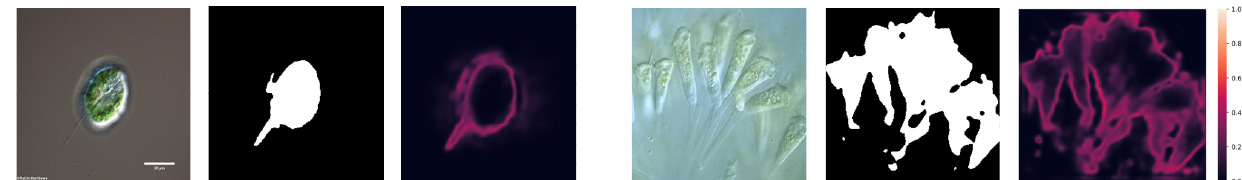
Figure 3. Possibility of prediction failure calculated using the uncertainty feedback module. Table 1. Detailed parameters of each module within the network. P: pooling; U: upsample; S: sig- moid.